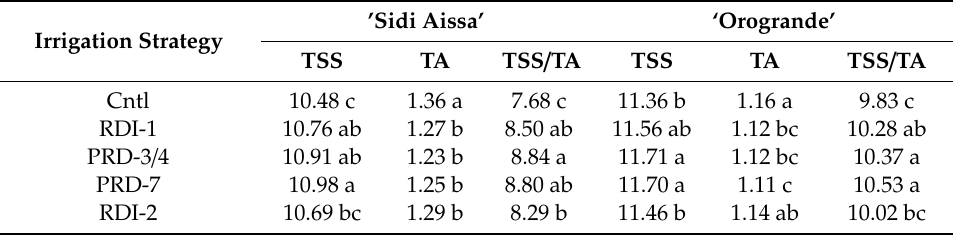
Table 8. E ff ect of irrigation strategies on juice total soluble solids (TSS, in %), titratable acidity (TA, in